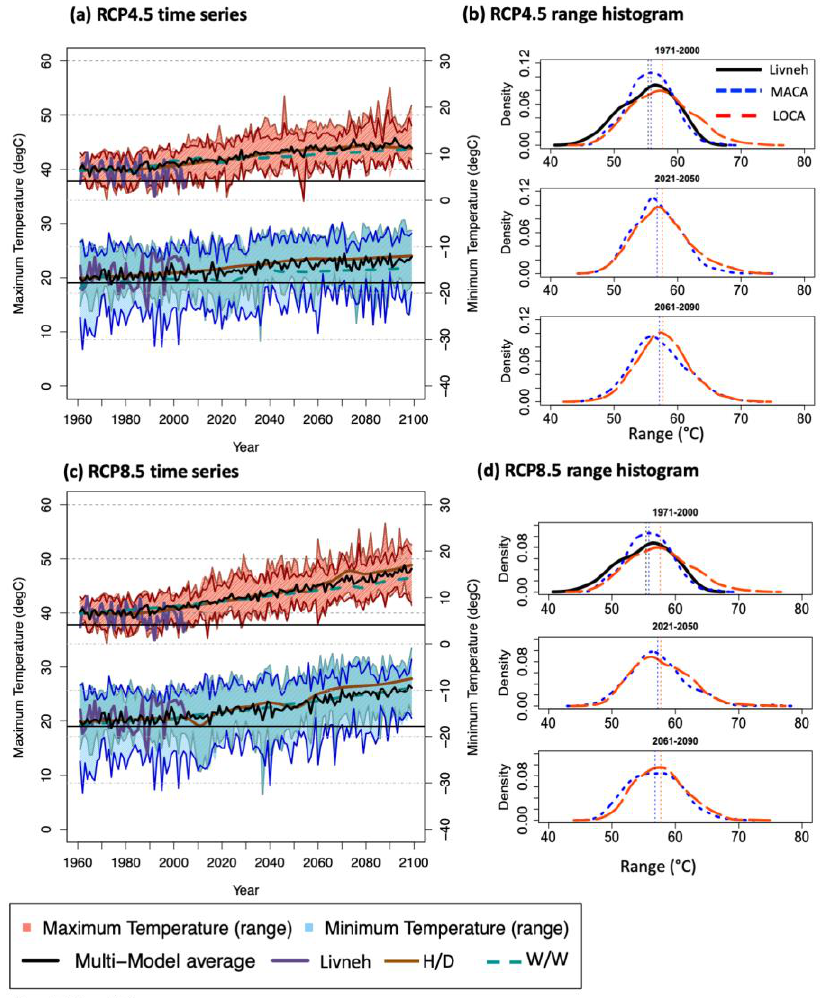
Figure 3. Time series ( left ) of historical and future climate model projections (1960–2099) in highest daily maximum, (June–August) and lowest daily minimum temperatures (December–February) in °C. Panel ( a ) is RCP4.5; panel ( c ) is RCP8.5. Lines depict the multi-model mean (black line) and the shaded polygons indicated the maximum–minimum temperature range across the full ensemble of projections, for MACA projections only (shaded + stippling), and for LOCA projections only (shaded). Time series for HD and WW model average values are smoothed using the ‘supsmu’ function in R. Observations (Livneh) is the thick purple line. On the right are probability density distributions of annual temperature ranges during 1971–2000 ( top ), 2021–2050 ( middle ) and 2061–2090 ( bottom ) for ( b ) RCP4.5 and ( d ) RCP8.5. Livneh, MACA and LOCA line legend is shown in the top panel of ( b ).